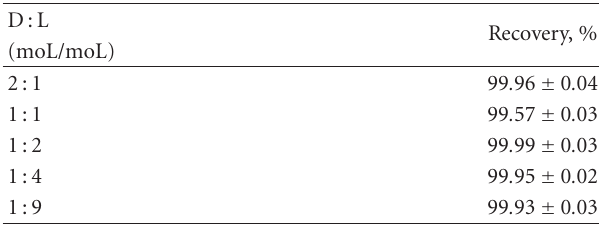
Table 4: The results obtained for the determination of D-glyceric acid in the presence of L-glyceric acid a .